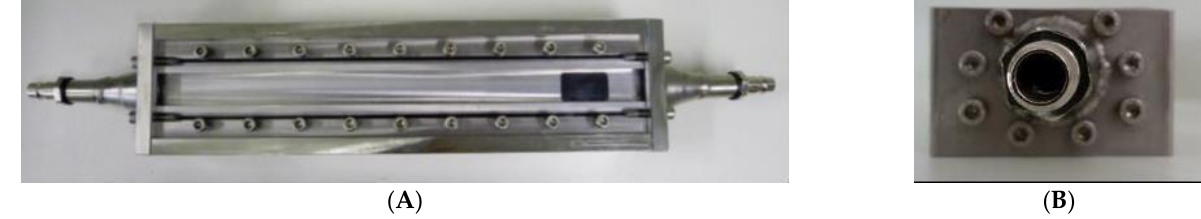
Figure 3. The interchangeable flow channel with a height of 5 mm: ( A ) top view of the flow channel and ( B ) side view of the flow channel.